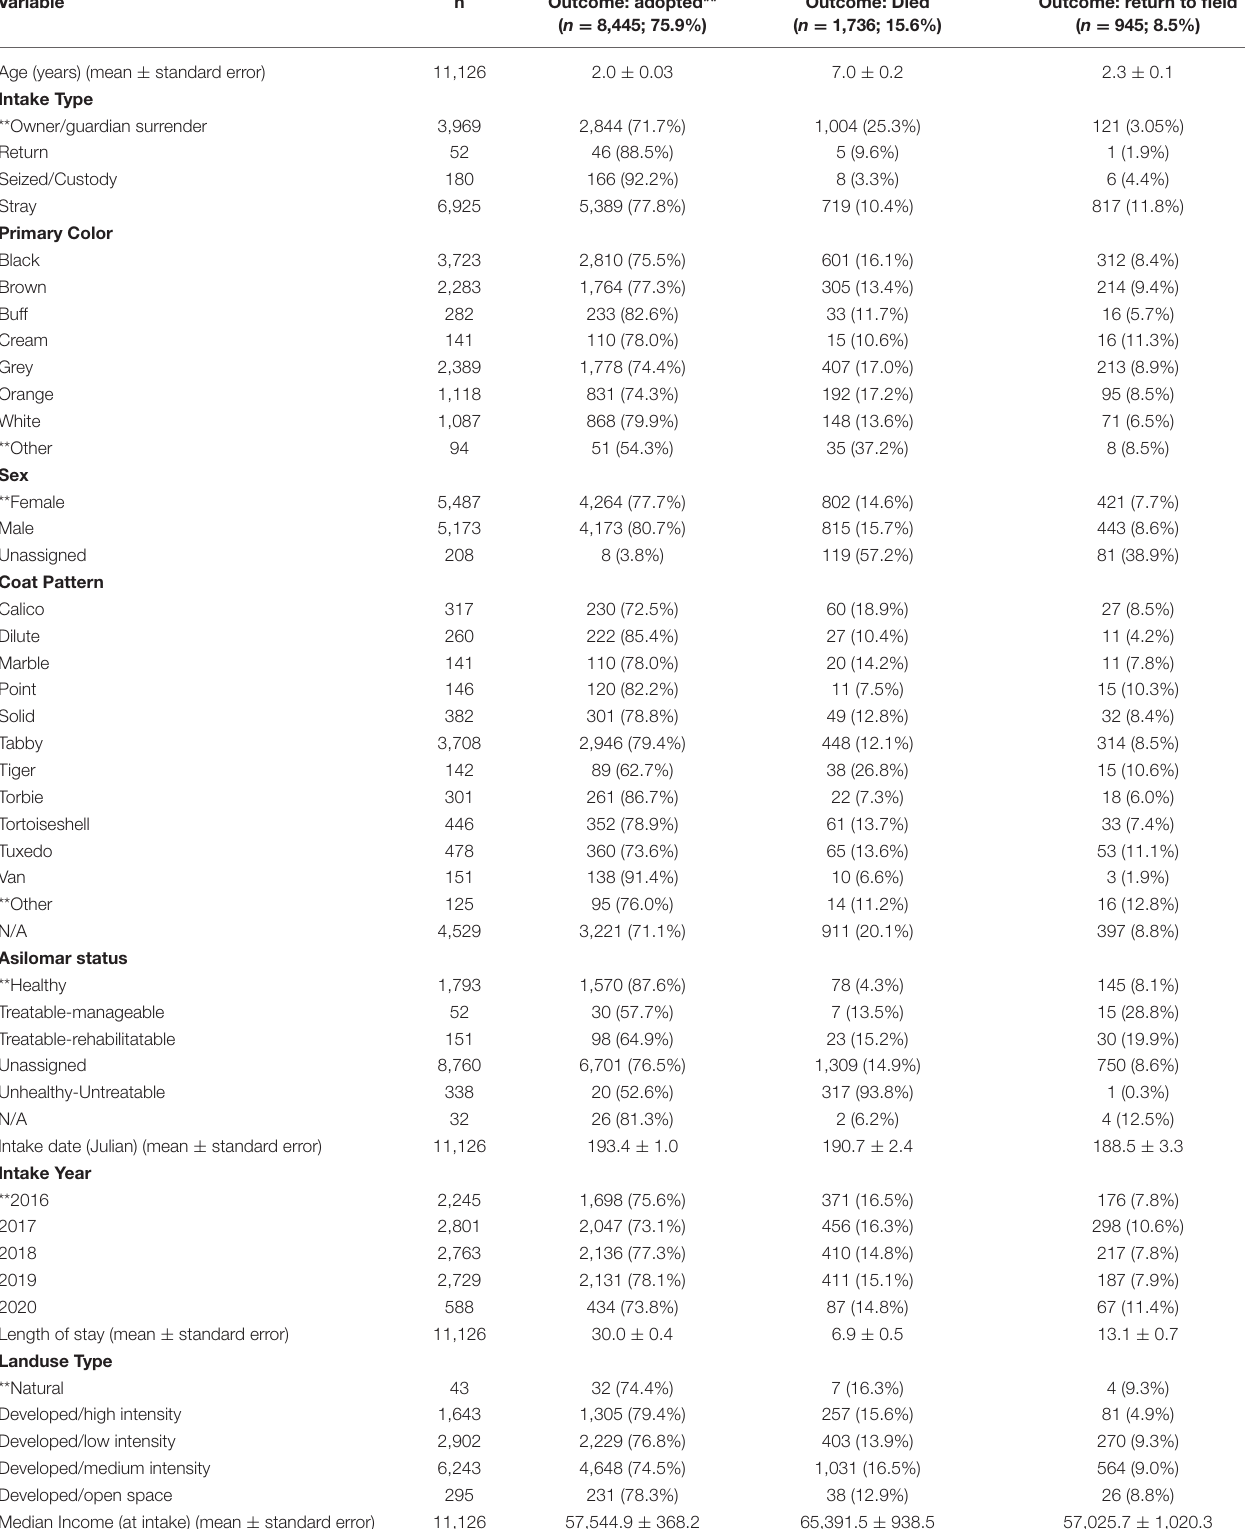
TABLE 1 | Summary statistics for outcome types across variables used in this study, from July 2016 through May 2020.